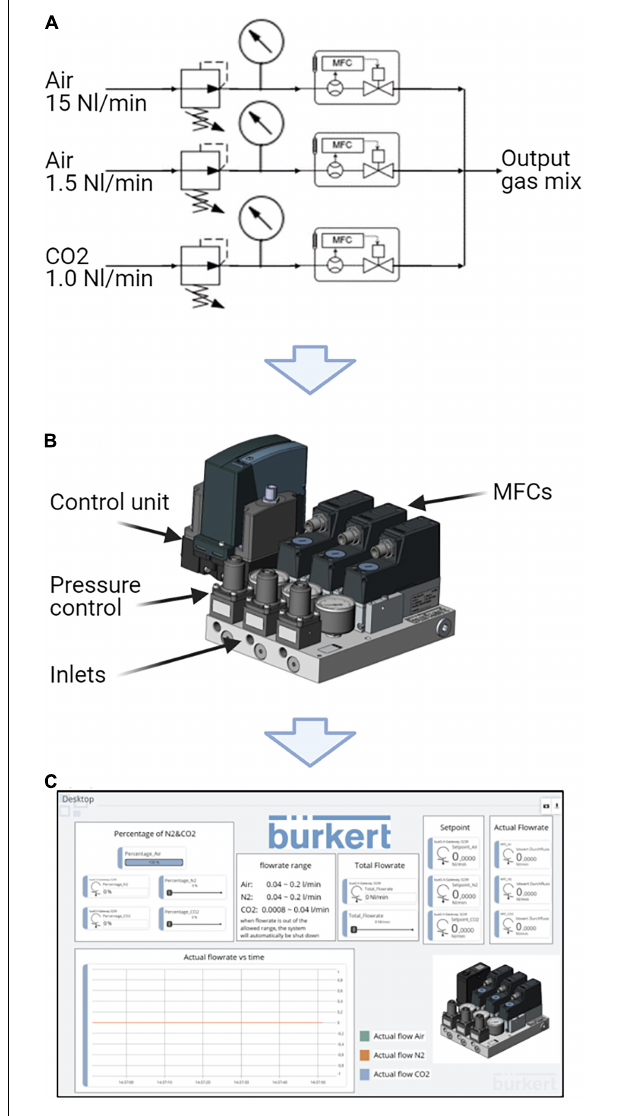
FIGURE 2 | Gassing unit of the novel flat panel gas-lift photobioreactor. (A) Schematic structure of the fumigation unit, including three parallel mass flow controllers (MFCs). (B) Outer appearance of the fumigation unit developed in cooperation with the cooperation partner Christian Bürkert GmbH & Co. KG. (C) Overview of an exemplary user interface, which can be adjusted according to the experimental requirements. Features of the software comprise real time parameter monitoring and creation of quick access